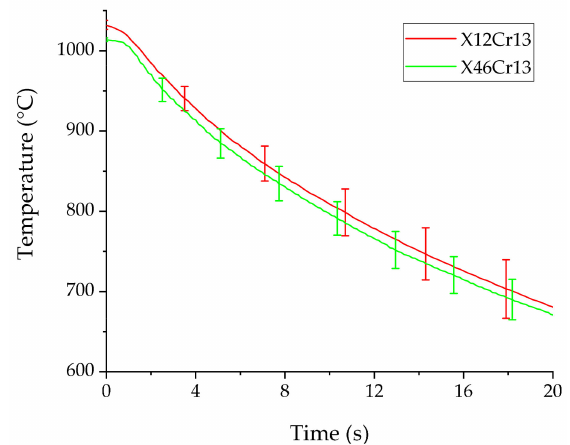
Figure 6. Exemplary cooling behavior of X12Cr13 and X46Cr13 after austenitizing at 1050 ◦ C for 300 s and subsequent cooling in still